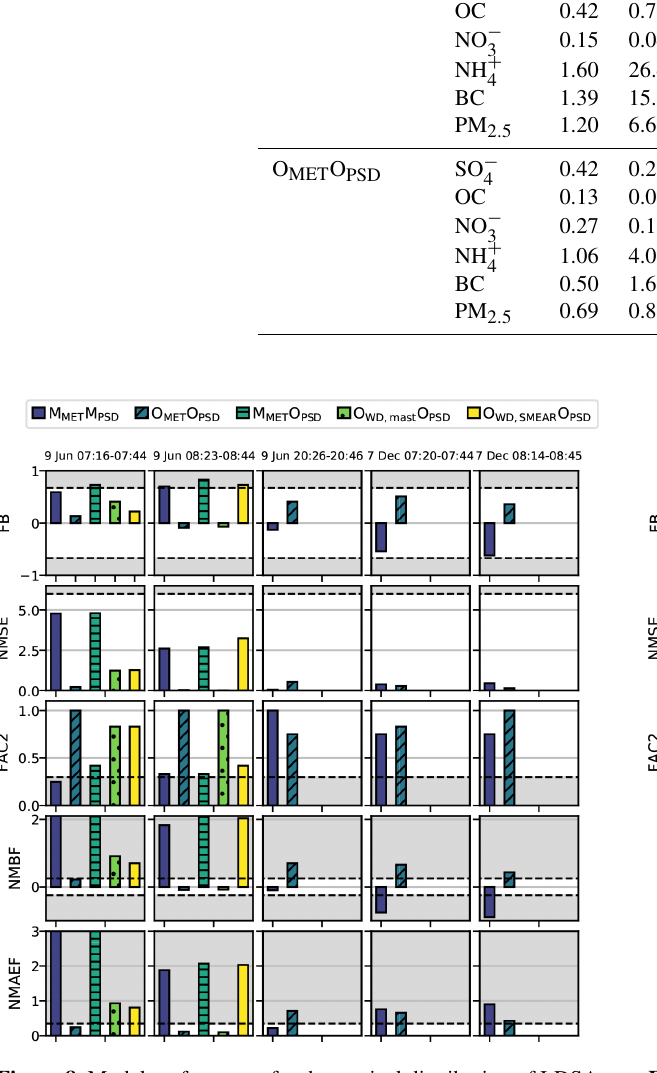
Figure 8. Model performance for the vertical distribution of LDSA at the supersite. The grey area indicates that the value exceeds the acceptance criteria given in Table 5. See Fig. 4 for details.